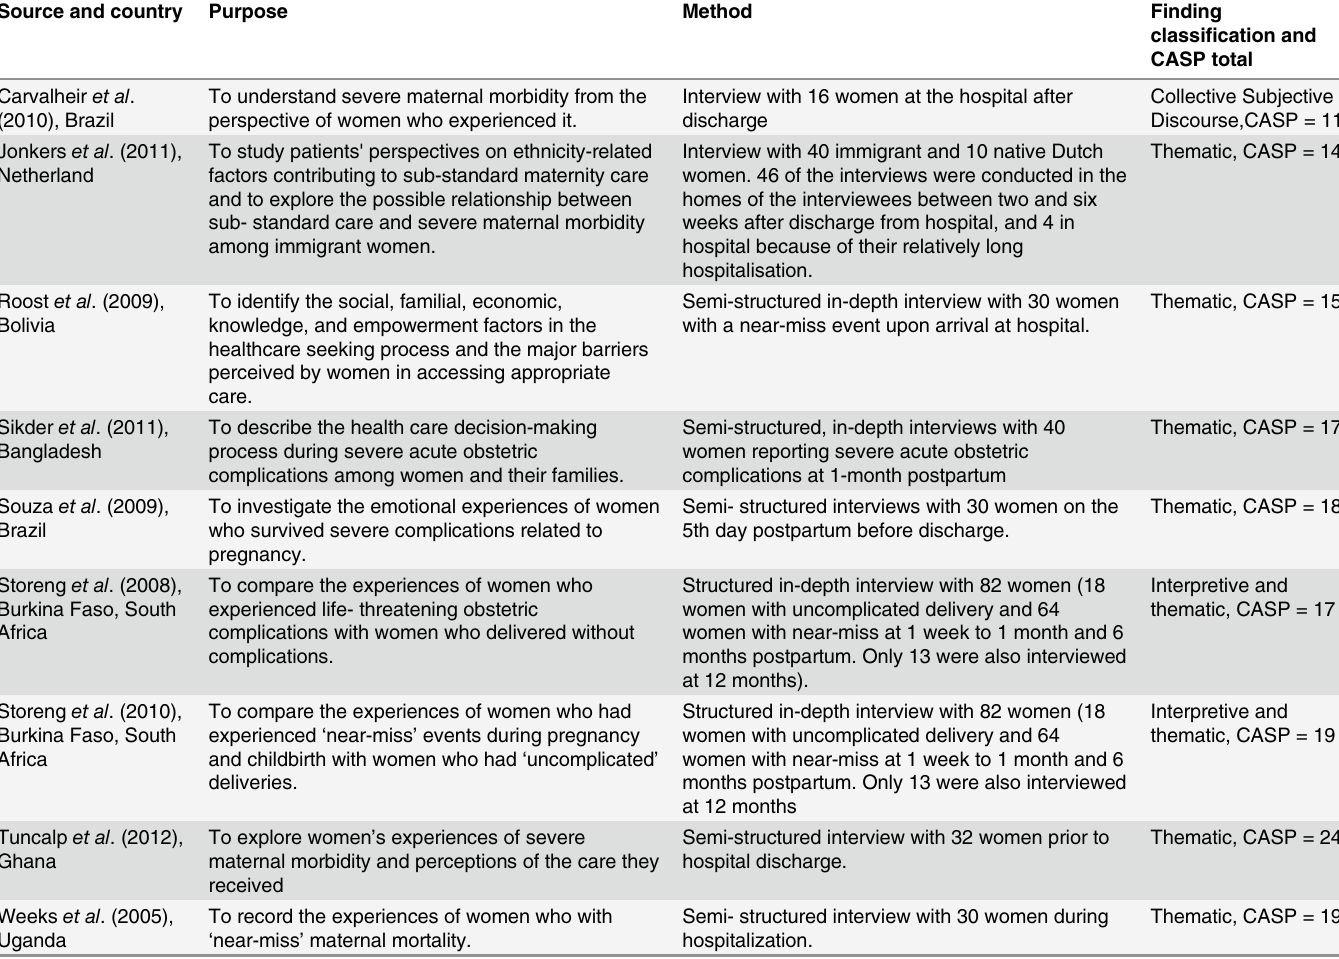
Table 1. Summary of articles in the